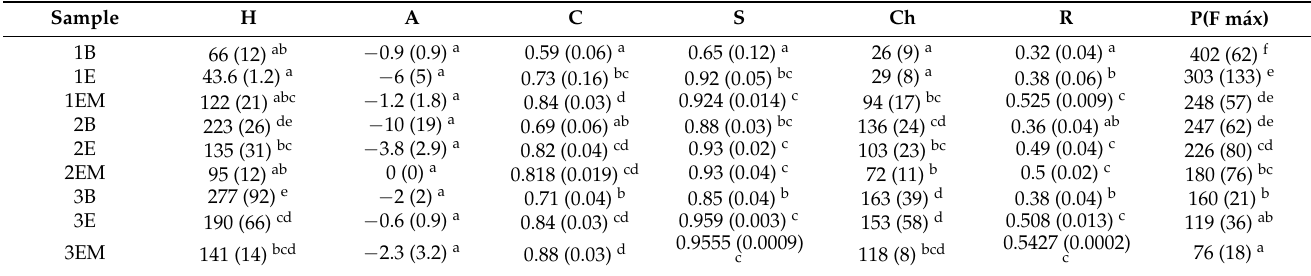
Table 3. Mean values and standard deviation in brackets of TPA test parameters and crust puncture (H: hardness; A: Adhesiveness; C: cohesiveness; S: springiness; Ch: chewiness; R: resilience;